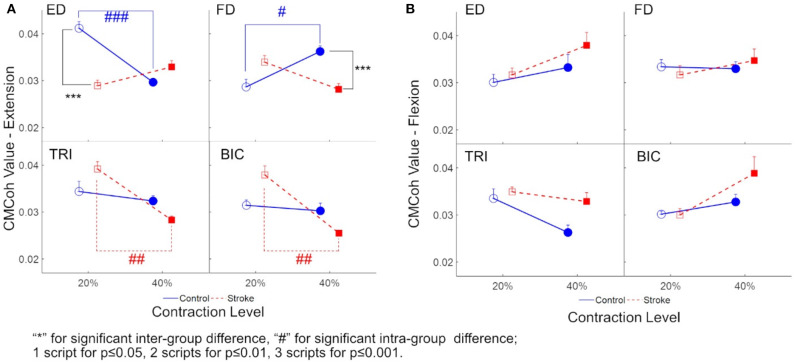
(A) The peak CMCoh values of each muscle (i.e., ED, FD, TRI, and BIC) of both groups (the control group: circles; and the stroke group: squares) in 20 and 40% Exs; (B) The peak CMCoh values for the muscles of both groups in 20 and 40% Fxs. 1 superscript for p ≤ 0.05, 2 superscripts for p ≤ 0.01, 3 superscripts for p ≤ 0.001. The significant inter-group difference is indicated by * (independent t-test), and # is used to indicate the significant intra-group difference (paired t-test).